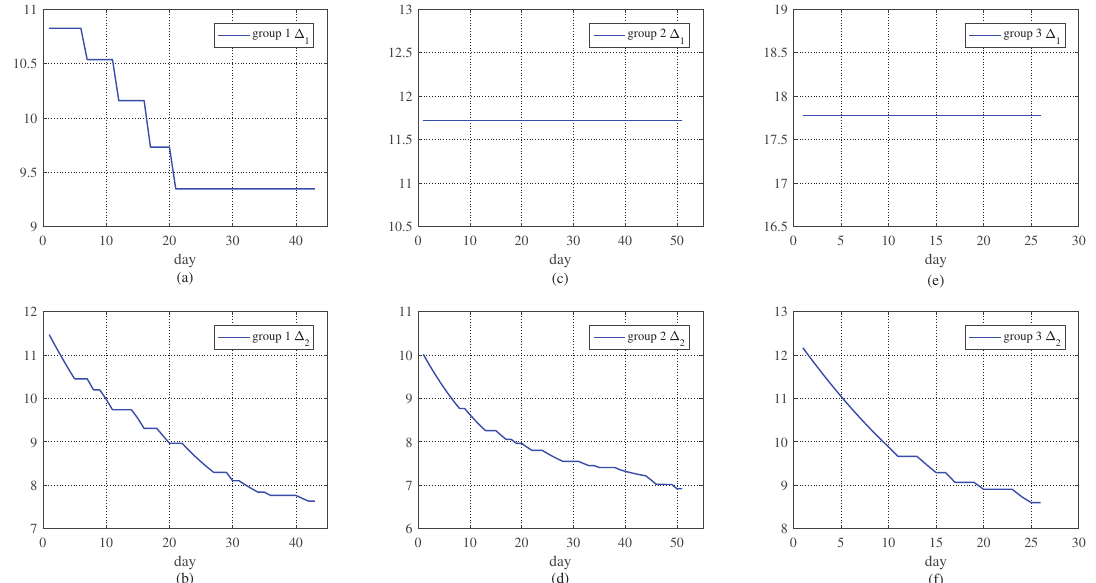
Figure 11. The results of ASPF applied to compensate the solar PV predicted by MLR. ( a , c , e ) are the trend of ∆ 1 in group 1, group 2 and group 3. ( b , d , f ) denote the ∆ 2 in group 1, group 2 and group 3